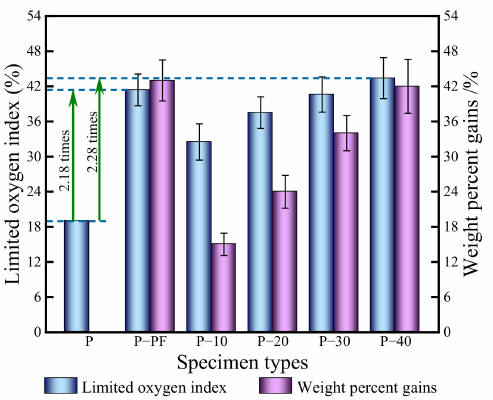
Figure 7. Limiting oxygen index of control and modified wood specimens. P—control; P-PF— specimens with 40% PF concentration; P-10, P-20, P-30, and P-40—BPF specimens with 10, 20, 30, and 40% resin concentration, respectively.